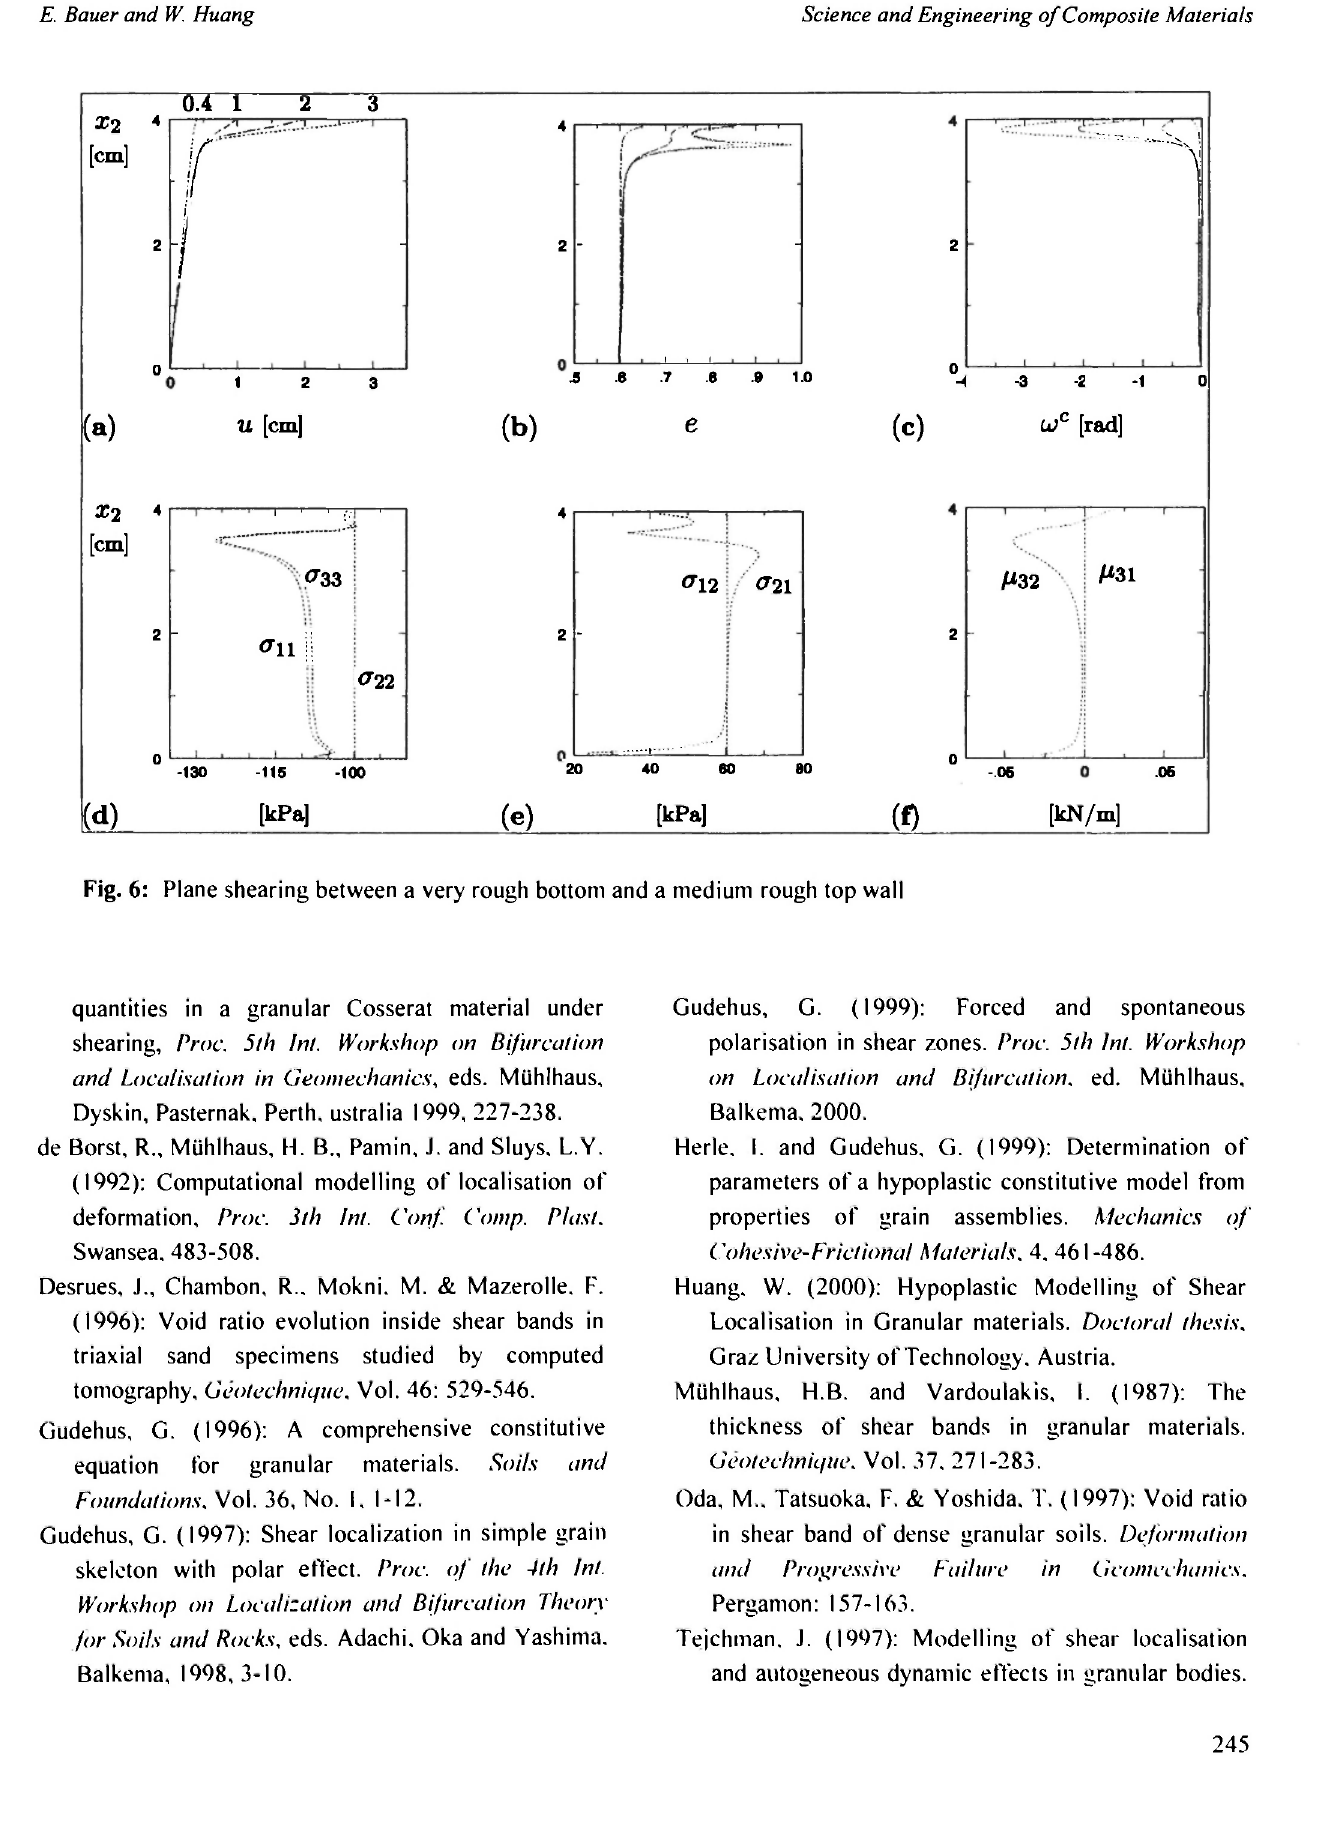
quantities in a granular Cosserat material